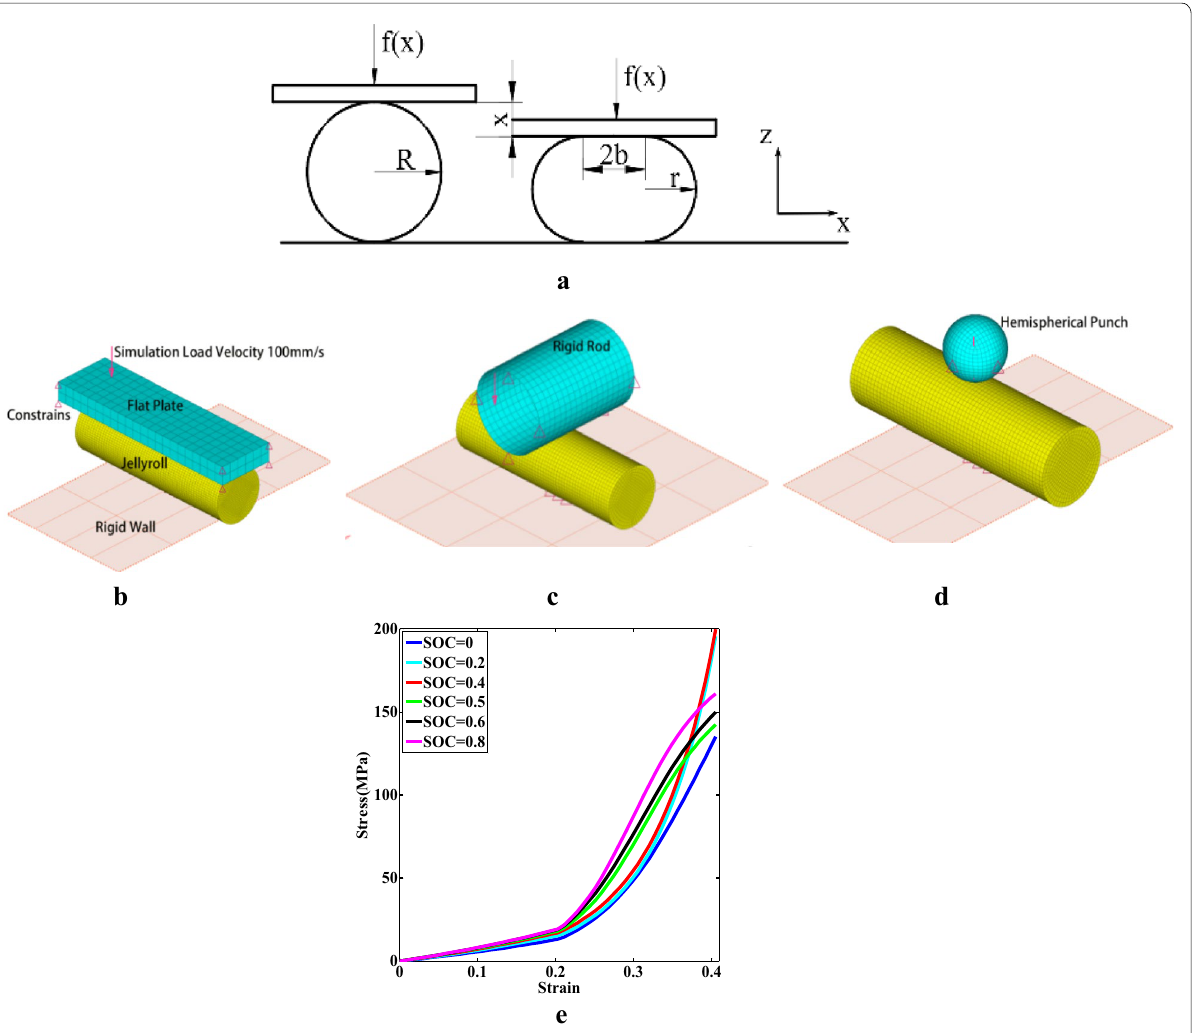
The material model requires two key inputs: stress- body strain datasets and tensile stress cutoff value (TSC). The real stress-strain value shown in Figure 7e can be used as the stress-body strain, and the TSC is 10 MPa. The simulation elements are shown in Fig- ure 7b ‒ d. In LS-Dyna, the properties are solid and the material model is crushable-foam for jellyroll. The properties and material for the flat plate are solid and rigid, while those for the rigid rod and hemispheri- cal punch are shell and rigid. The jellyroll was divided with a mesh size of 1 mm and 46200 elements. If the simulation velocity is 0.5 mm/min, then the com- pression speed will yield an unacceptable calculation time. Meanwhile, the high compression speed can be